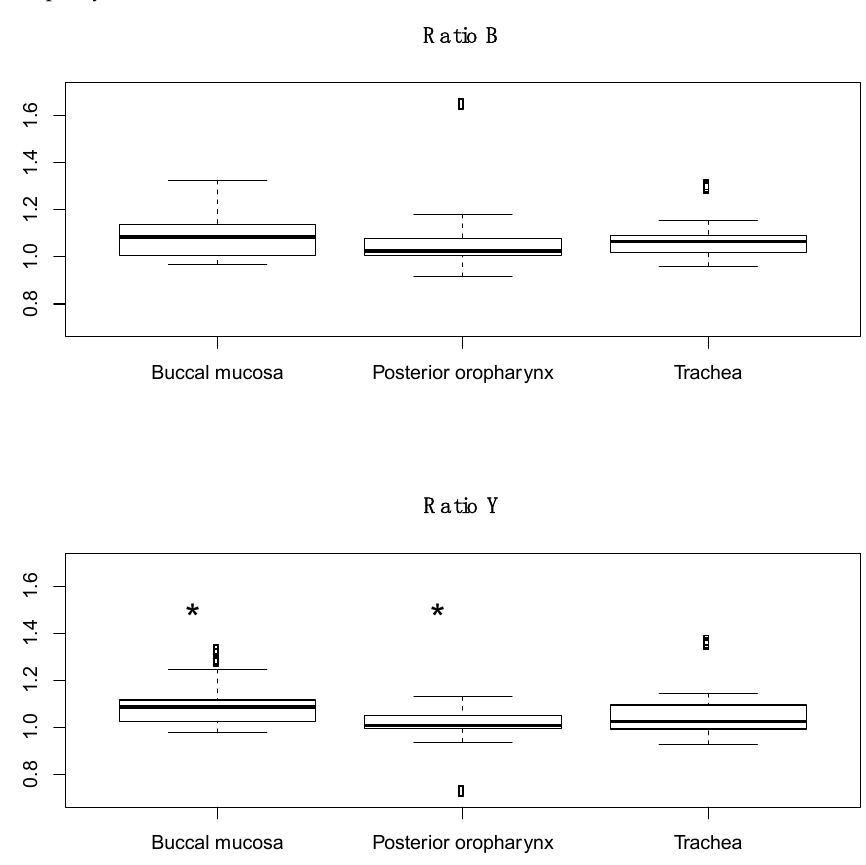
Figure 3. Boxplots of ratio B and ratio Y for buccal mucosa, posterior oropharynx, and tracheal tissues from healthy human subjects. Dots in the boxplots are outliers, defined as being 1.5 times the interquartile range beyond the first and third quartiles. * p < 0.01 compared to trachea. Subjects with inhalation injury were less likely to be male and had greater body mass index as compared to subjects with no inhalation injury. There were no significant differences between subjects in age, % total body surface area burn, or 24 h resuscitation volumes. The average inhalation injury score was 1.9 ± 0.9. Scores were calculated from an average of 3.4 images per subject (range 2–6). A total of 39 and 27 spectral scans were